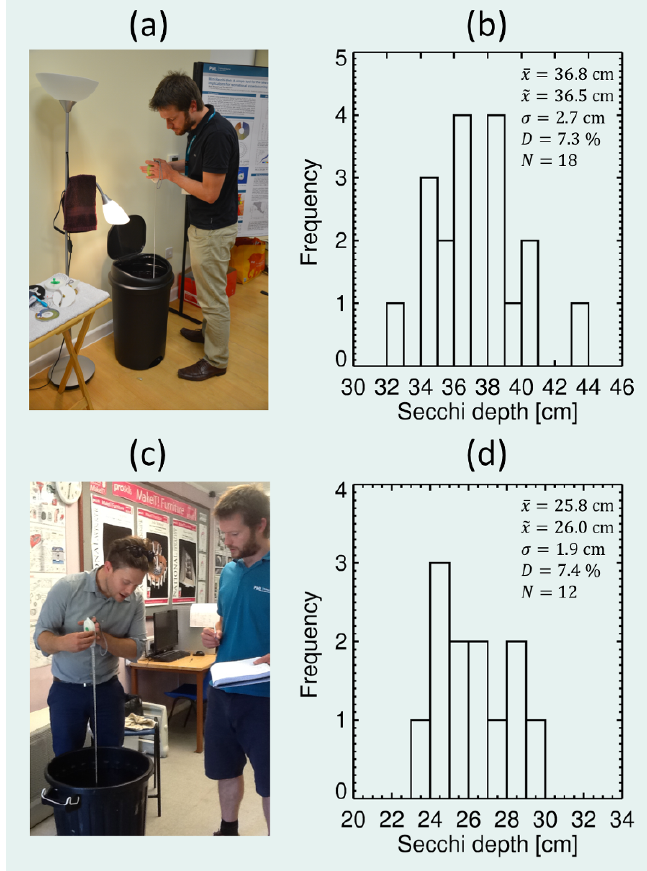
Figure 9. Quantifying uncertainty arising from different individuals reading the Secchi